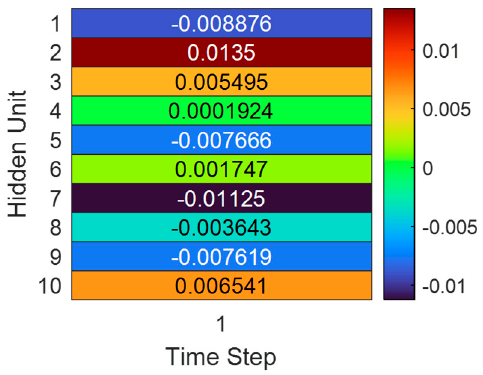
Figure 15. Activations of LSTM Layer—the first 10 out of 4400 activations. The fourth layer is fully connected. In this layer, the weight matrix is multiplied by the numeric input values, and the bias vector is added. In the tomographic image, the fifth regression layer generates values of 11,297 pixels. Finally, color shades are created by converting the real values of pixels.